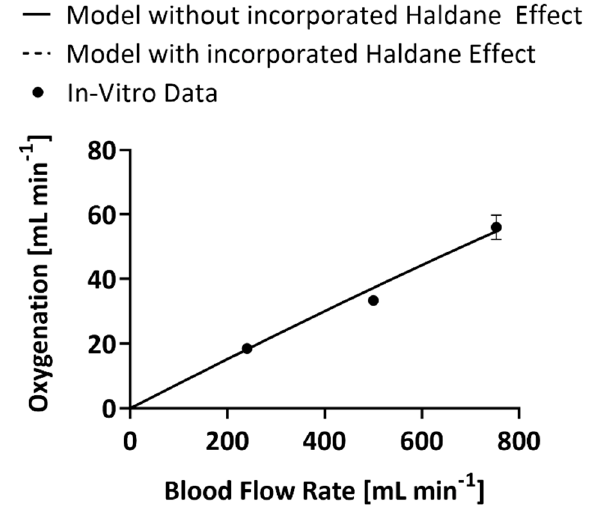
Figure 2. In vitro values of the oxygenation rate of the experimental HFM bundle compared to predictions of oxygenation by the model that accounts for the Haldane effect and the one that does not [18].